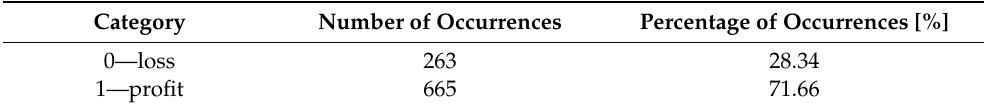
Table 4. Number and percentage of companies that made a profit or a loss.